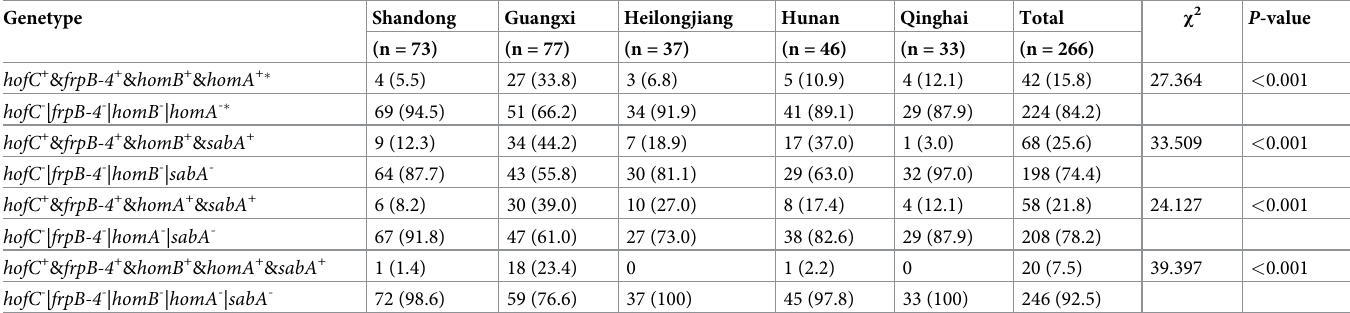
Table 5. Prevalence of combined H . pylori hofC , frpB-4 , homA , homB , sabA in different regions.